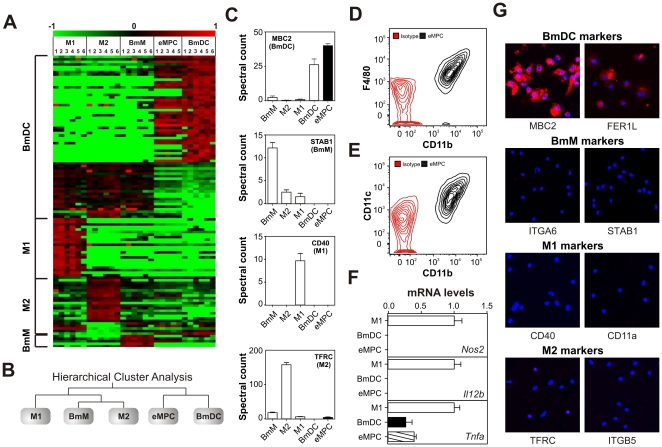
Mass spectrometric and immunohistochemical staining of thioglycolate-elicited peritoneal cells (eMPCs), polarized macrophages, and DCs.
Panels A–B: Hierarchical cluster analysis of eMPCs. Cells were harvested from the peritoneal cavity of C57BL/6J-Ldlrtm1Her mice 5 days after intraperitoneal injection with thioglycolate. Isolated plasma membrane proteins detected by LC-MS/MS analysis of eMPCs were subjected to hierarchical cluster analysis, using the 107 proteins identified as differentially expressed by myeloid cells generated in vitro (
Fig. 2
). Panel B: Relationships among eMPCs, M1 cells, M2 cells, BmMs, and DCs, as determined by cluster analysis. Panel C: Protein expression in eMPCs, M1 cells, M2 cells, BmMs, and BmDCs. Protein levels were quantified by MS/MS and spectral counting. Data are presented as means and SDs. Panels D–E: Flow cytometric analysis of CD11b, CD11c, and F4/80 in eMPCs. Results are presented as contour plots with 10% probability increments. Panel F: qRT-PCR analysis of M1 marker genes (Nos2, Il12b, Tnfa) in M1 macrophages, BmDCs, and eMPCs. Results (means and SEMs; N = 6) were standardized to 18S levels and expressed relative to M1 macrophages. Panel G: Immunostaining of eMPCs. Cells were stained with antibodies (red channel) to plasma membrane proteins differentially expressed by BmDCs (MBC2, FER1L), BmMs (ITGA6, STAB1), M2 cells (TFRC, ITGB5), and M1 cells (CD11a, CD40). Nuclei were visualized by DAPI staining (blue channel). Immunostaining and microscopy were performed on the same day and with identical microscope settings to experiments presented in
Fig. 3D
 and Fig. S3. Results obtained for flow cytometry, qRT-PCR, and immunocotyochemistry are representative of 3 independent analyses.